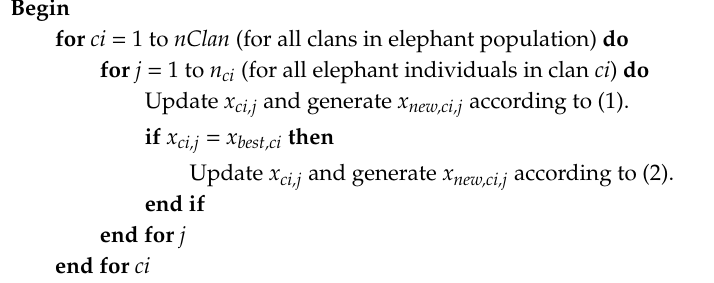
Algorithm 1: Clan updating operator [12]